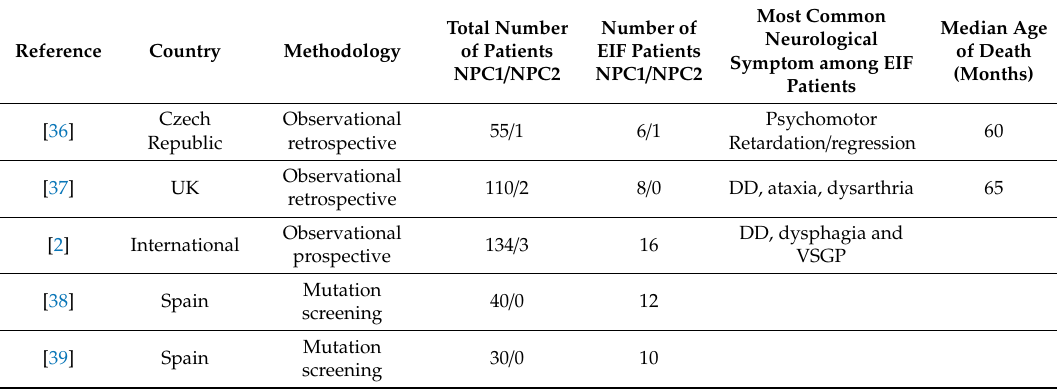
Table 1. Summary of the Niemann Pick disease type C (NPC)